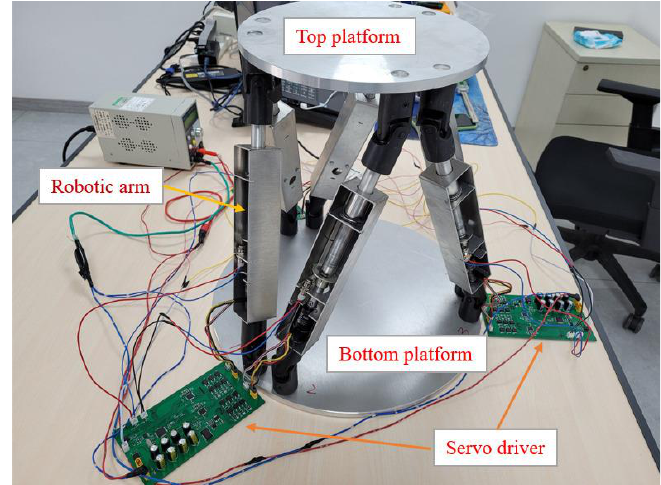
Figure 24. The physical six degree of freedom parallel platform.